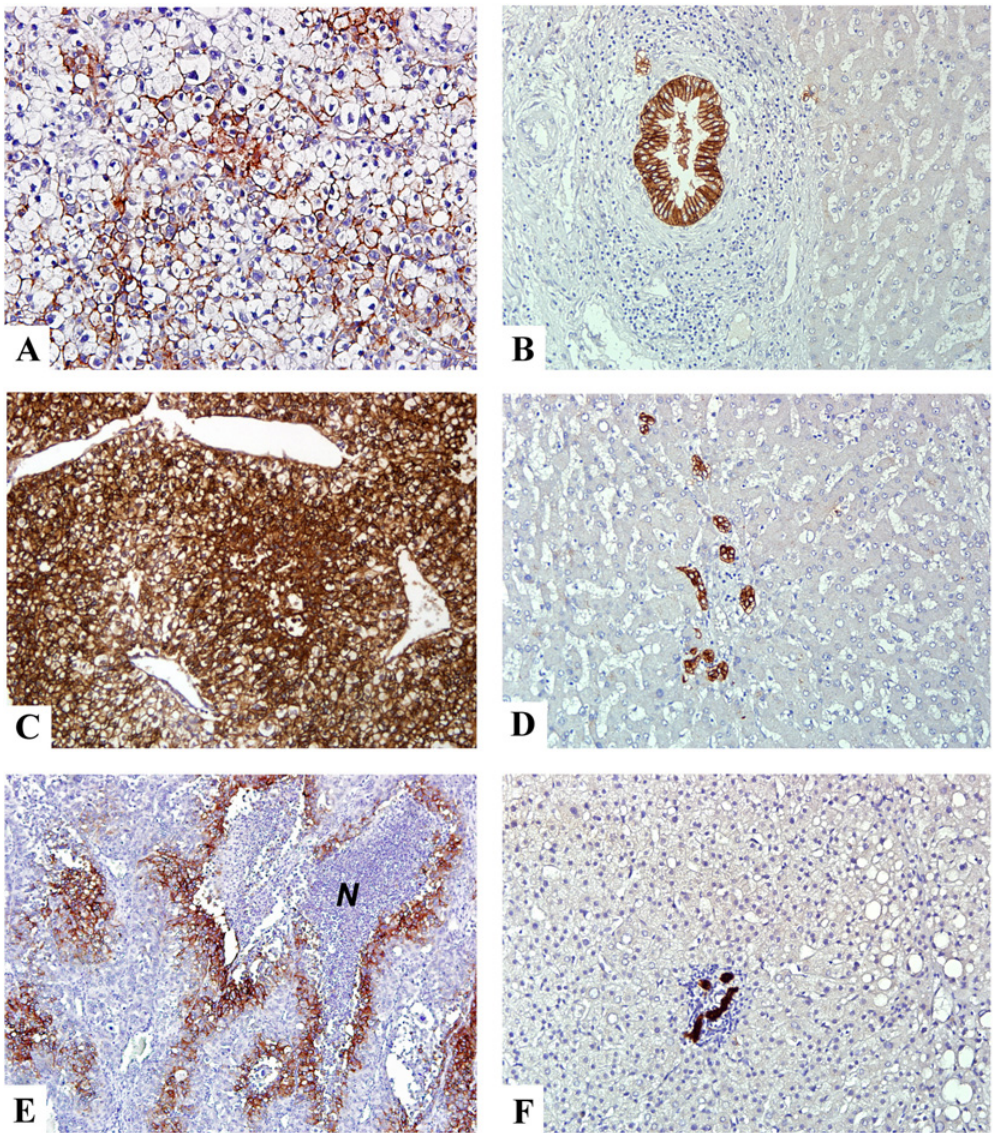
Fig 1. Expression of CA-IX protein in non-cancerous liver parenchyma and HCC. (A and C) Immunohistochemical staining showed heterogeneous and diffuse membranous/cytoplasmic expression of CA-IX in HCC. (E) In the region of tumor necrosis, the viable tumor cells surrounding the necrotic area ( N ) exhibited strong CA-IX expression. (B, D, F) B, D, and F were the nontumorous counterpart of A, C, and E, respectively. They exhibited strong staining in the bile duct epithelial cells in the portal area but not in the hepatocytes or the mesenchymal cells. A-F x200 (original magnification).